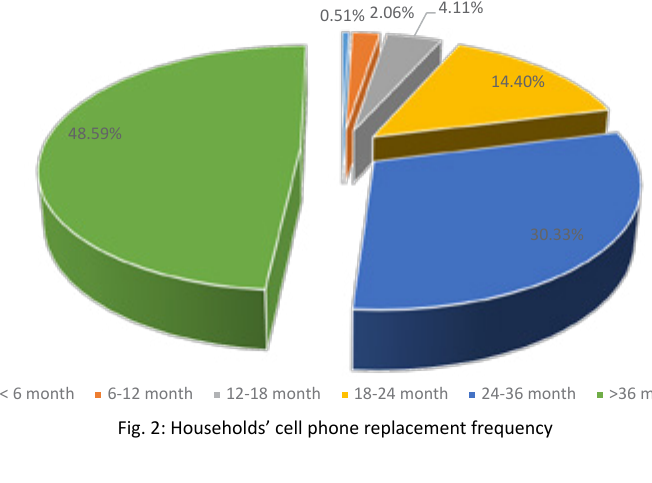
Fig. 2: Households’ cell phone replacement frequency Fig 2: Households’ cell phone replacement frequency